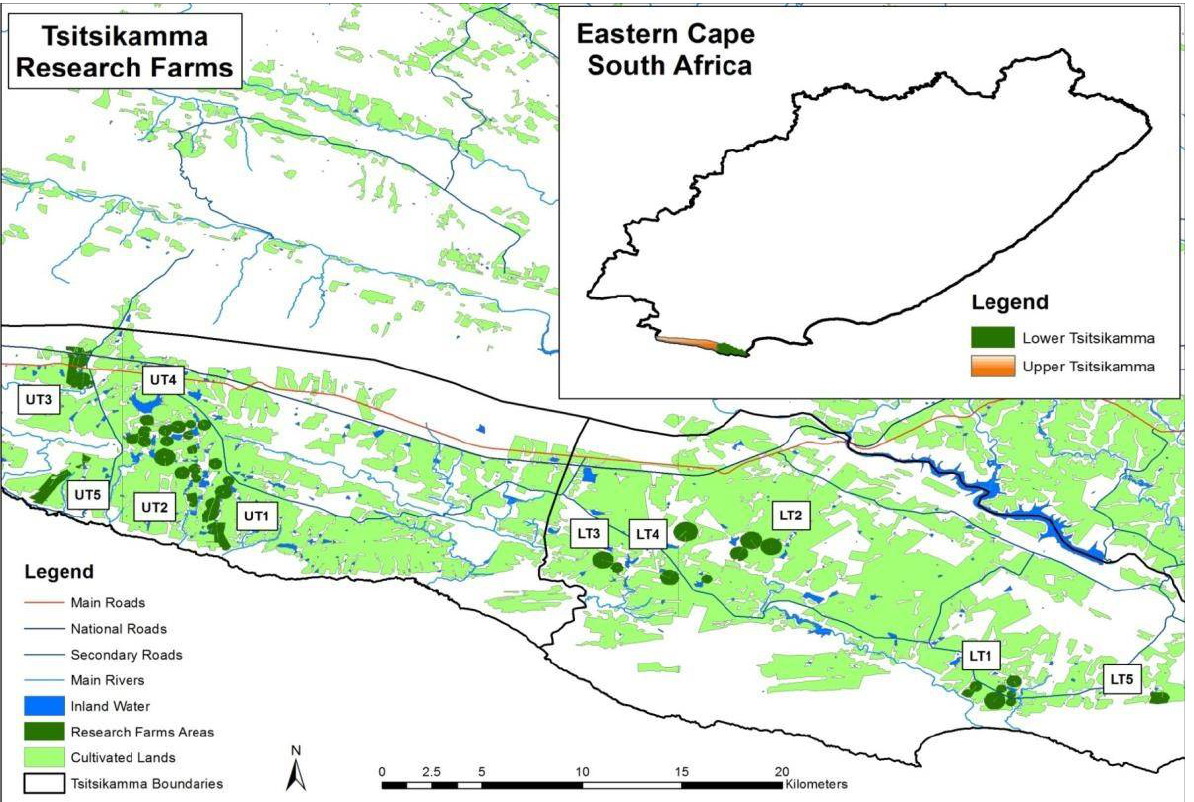
Figure 1. Sampled farms in the Upper (UT) and Lower (LT) Tsitsikamma. This study was carried out on 10 pasture-based dairy farms in the Tsitsikamma of which an equal number (five farms per region) was selected in the UT and LT regions based on the following criteria: (1) pasture mixtures consisting of kikuyu, ryegrass, and clover; (2) adopted minimum tillage or no tillage practices; (3) six years established pasture mixtures; (4) irrigated pasture mixtures; and (5) availability of accurate fertilizer application rates from the last 6 years. Although the farms have the above in common, they differ in their management practices, e.g., they have varying fertilizer application rates, irrigation frequencies and grazing tendencies (Table 1). However, there were no available records on irrigation frequencies. Unscreened 2 t ha − 1 of poultry manure and unknown rates of solid dairy effluent were spread in some farms, while liquid dairy effluent was applied with irrigation water via the center pivot system. None of these organic wastes’ chemical composition was determined. However, in general, the application of N, P, and K through either solid or liquid dairy effluent should be negligible compared to poultry manure which Table 1. Soil management in the irrigated Upper (UT) and Lower (LT) Tsitsikamma dairy farms. Region Farm